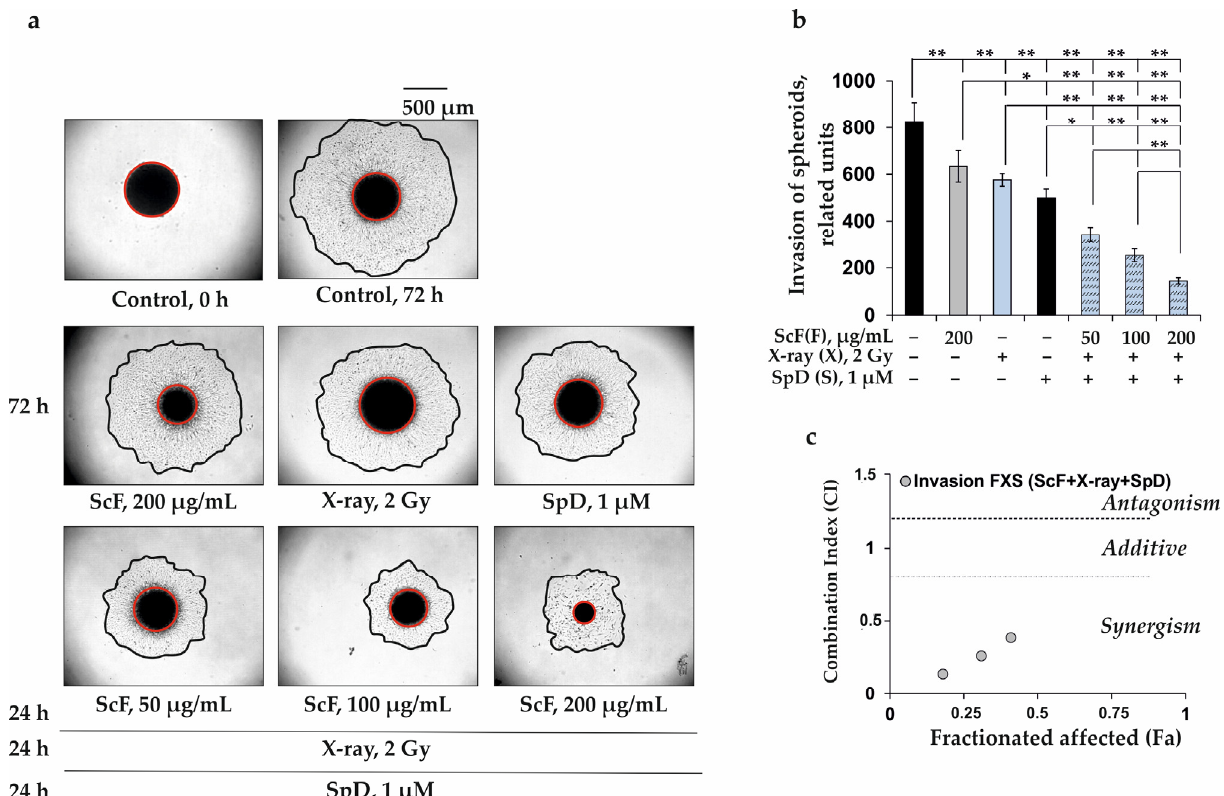
Figure 6. The combined radiomodifying effect of fucoidan from S. cichorioides (ScF) with X-ray and pacificusoside D from S. pacificus (SpD) on the invasion of 3D human melanoma cells SK-MEL-2. ( a ) Photographs of SK-MEL-2 spheroids (40 × , scale 500 µ m) after invasion into the gelatin matrix for 72 h treated with ScF (50, 100, and 200 µ g/mL) in combination with X-ray (2 Gy) and SpD (1 µ M). ( b ) Quantification of invasion of spheroids treated with the combination of investigated compounds was performed using the ImageJ program and was determined as the difference between the area of invasion of spheroid cells and the area of the spheroid. Data show the mean of three independent experiments ± SD. A one-way ANOVA and Tukey’s HSD test for multiple comparisons indicated the statistical significance (* p < 0.05 and ** p < 0.01). ( c ) The Combination Index (CI) for the interaction between ScF, X-ray, and SpD was calculated using the Compusyn software (ComboSyn,